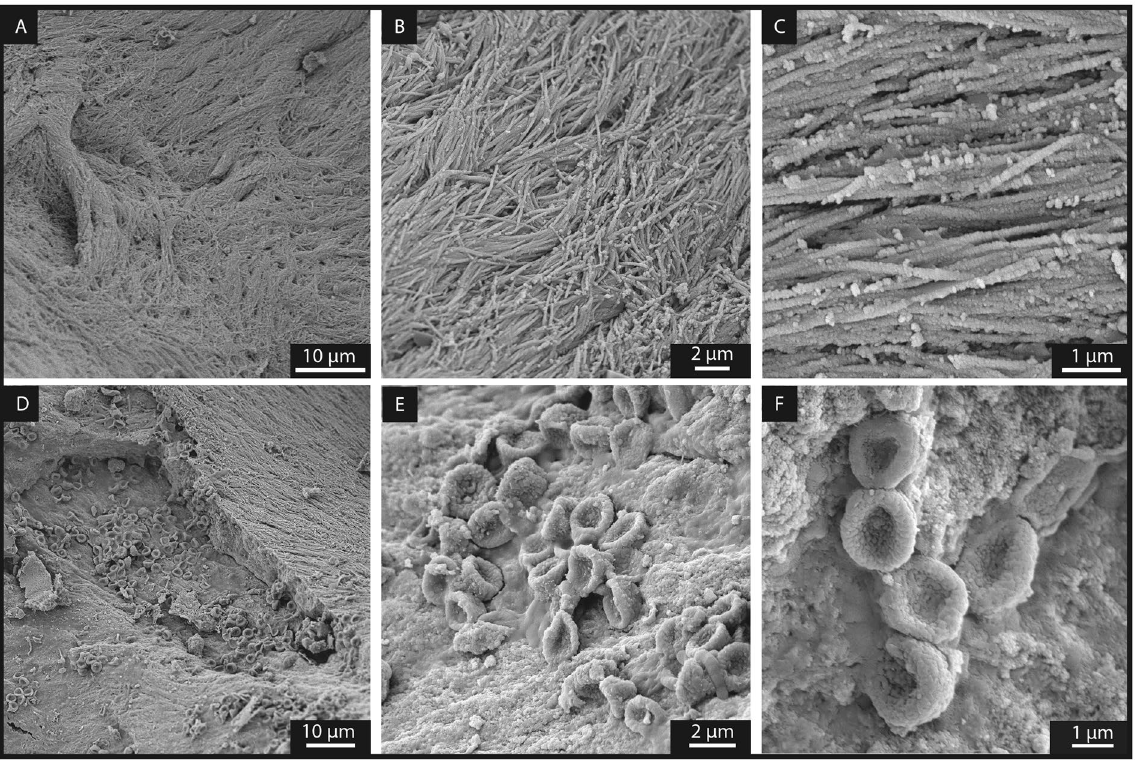
Figure 2. Secondary electron images of the trabecular bone following the removal of sparry calcite by light acetic acid treatment revealing exceptionally well-preserved soft tissues. ( A to C ) Represent collagen fibres 8 with increasing magnification. ( D to F ) Reveal RBC-like structures with increasing